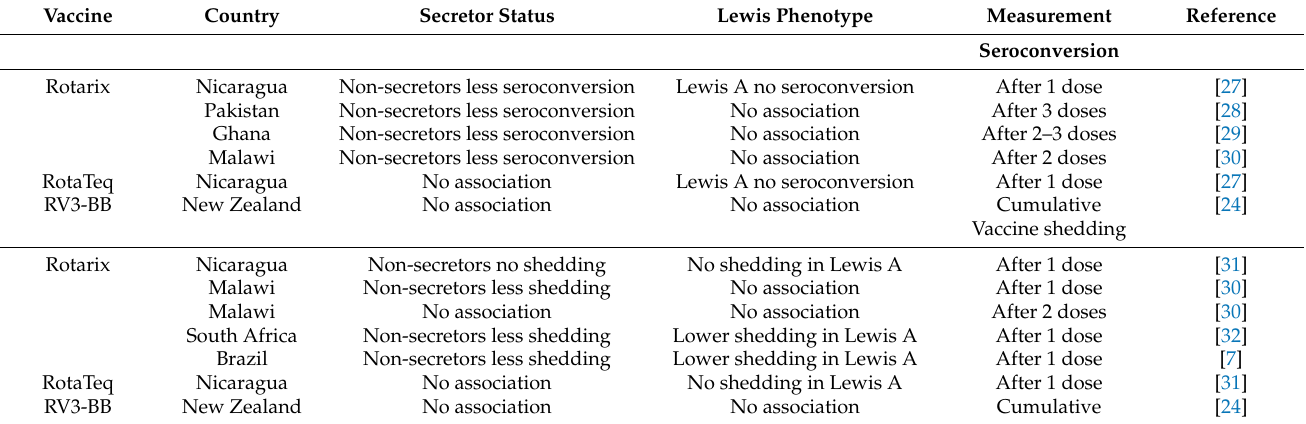
Table 1. Summary of different studies investigating the association between rotavirus vaccine take and secretor and Lewis status. Updated and modified from Reference